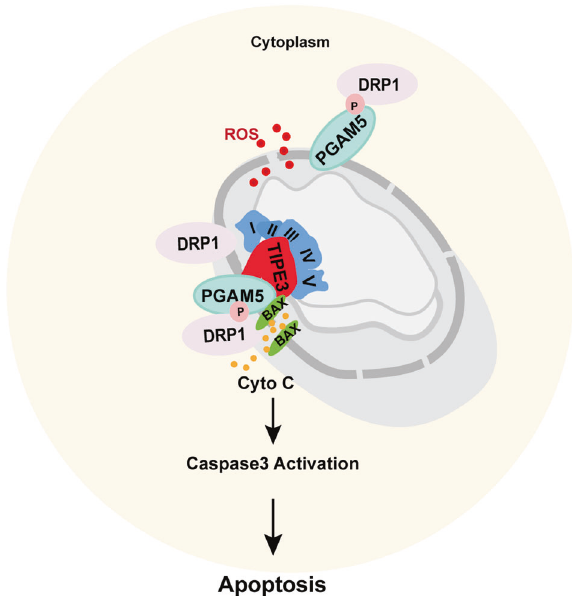
Fig. 8 Schematic model of the role of TIPE3 in regulating mitochondrial stress in HNSCC cells. HNSCC cells downregulate TIPE3 via promoter CpG island hypermethylation to avoid detri- mental mitochondrial stress during rapid proliferation. Overexpres- sing of TIPE3 increases PGAM5 targeting mitochondrial membrane to recruit BAX and facilitate p-DRP1 ser637 dephosphorylation and activation at ETC complex site of cristae, leading to mitochondrial membrane fragmentation, ROS accumulation, and cytochrome-c releasing, which ultimately induced HNSCC cell